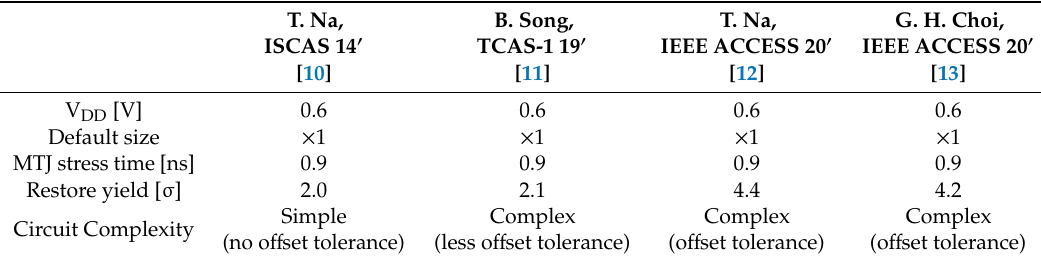
Figure 10. Restore yield of state-of-the-art NVFFs relative to the V DD when MTJ stress time is 1.5 ns and width size of all devices is equal to the default size times 4 ( × 4) during the sensing mode at SS corner. Table 1. Performance summary and comparison between the four state-of-the-art NVFFs [10–13] in case of V DD of 0.6 V.